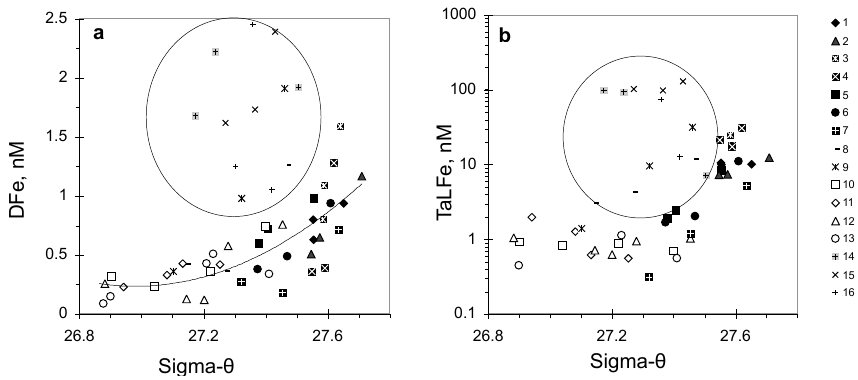
Fig. 3. Fe concentrations in relation to water density. (a) Dissolved Fe (DFe); (b) total acid leachable Fe (TaLFe). Open symbols are from Drake Passage waters. Closed symbols are from station close to or over the continental shelf. Note the change to a log scale ordinate for TaLFe. The stations within the circles are from the near-shore coastal survey (stations 8, 9, 15, 16) and station 14. Station numbers are shown in the column to the right.